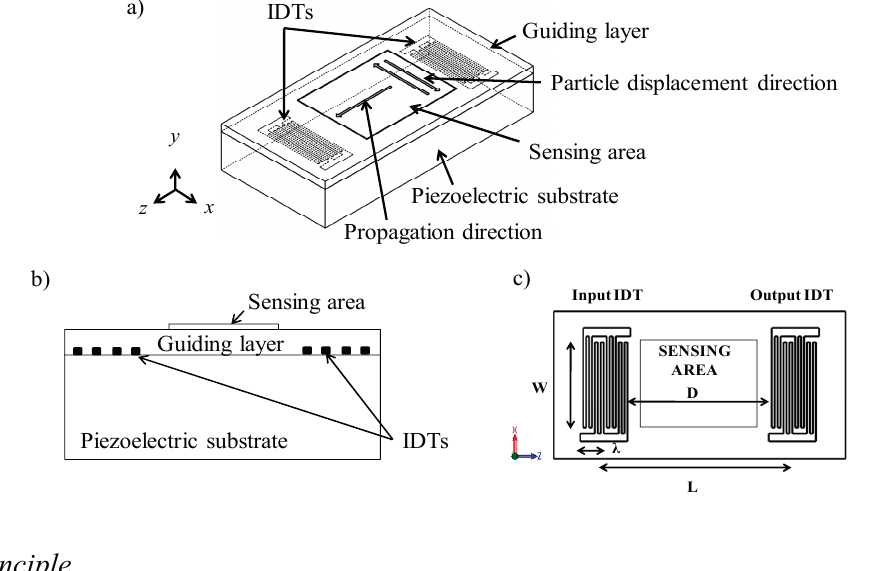
Figure 1. Basic structure of a LW delay line device: ( a ) Isometric view; ( b ) Cross-sectional view; and ( c ) Scheme of a LW delay line (upper view), where W is the acoustic aperture, D is the distance between input and output IDTs, L is the center-to-center distance between IDTs and λ is the acoustic wave wavelength set by the IDTs pattern